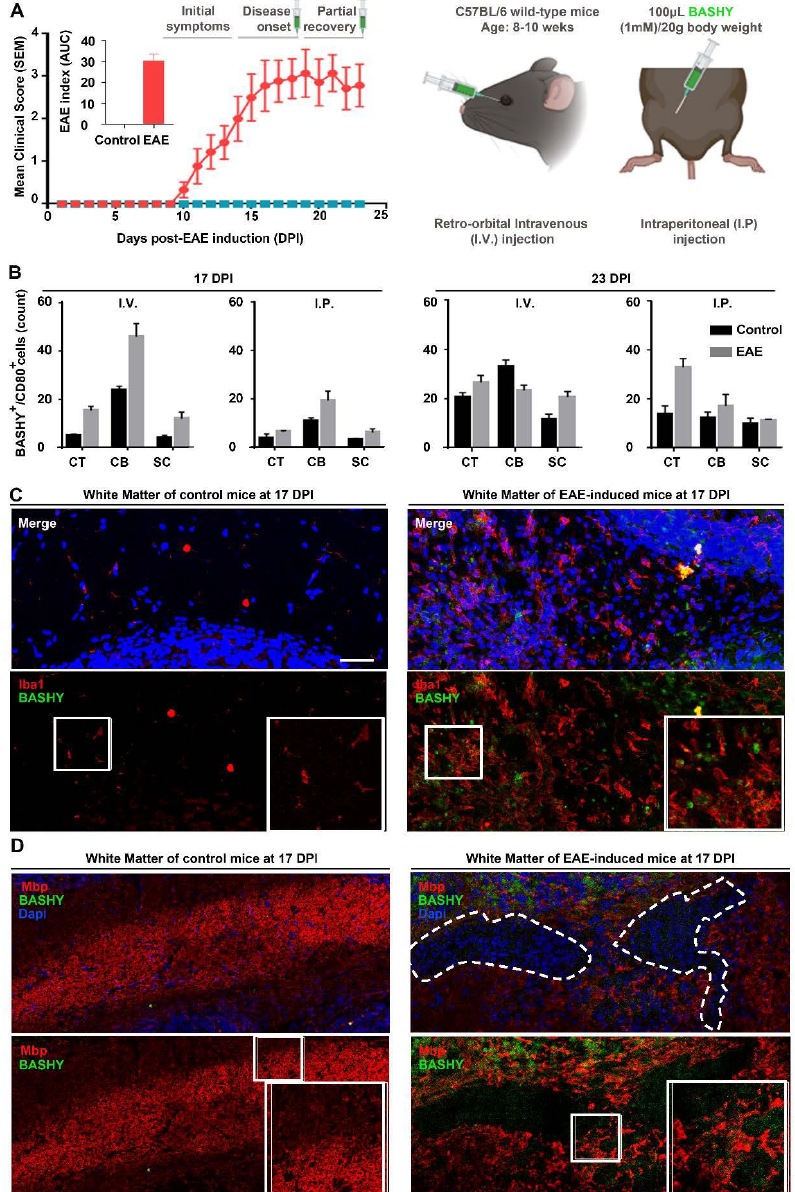
Figure 4. BASHY labels lesion-associated myelin-phagocytosing microglia in EAE-induced mice. ( A ) Clinical observations of control and EAE-challenged mice during 23 days after immunization, and global scheme of BASHY administration in vivo. Following EAE induction, mice clinical symptoms are characterized by an increase in paralysis beginning at the tail until animals reach quadriplegia and death. The clinical score was given during each day of the experiment following a 5-point standardized scale, and the area under the curve (AUC) of the overall disease severity was calculated for each mouse. A total of 100 µL of BASHY molecule was administered (1 mM/20 g body weight) at both 17 (disease peak) and 23 DPI either intravenously (I.V) or intraperitoneally (I.P). ( B ) Flow cytometry analysis was performed using cells from cortex (CT), cerebellum (CB), and spinal cord (SC) from control and EAE-induced mice injected with BASHY. Cells were probed with the antibody CD80 to stain for activated microglia. Panels ( C ) and ( D ) are representative images of brain sections from control and EAE-induced mice 17 DPI, injected with BASHY I.V. Brain sections were stained for microglia/macrophages (Iba1, red) in ( C ) or stained for cell nuclei (DAPI, blue) and compact myelin sheaths (myelin basic protein, Mbp, red) in ( D ) and imaged in the cerebellar white matter. Magnification 20X. Scale bar equals 200 µm (created with Biorender.com).